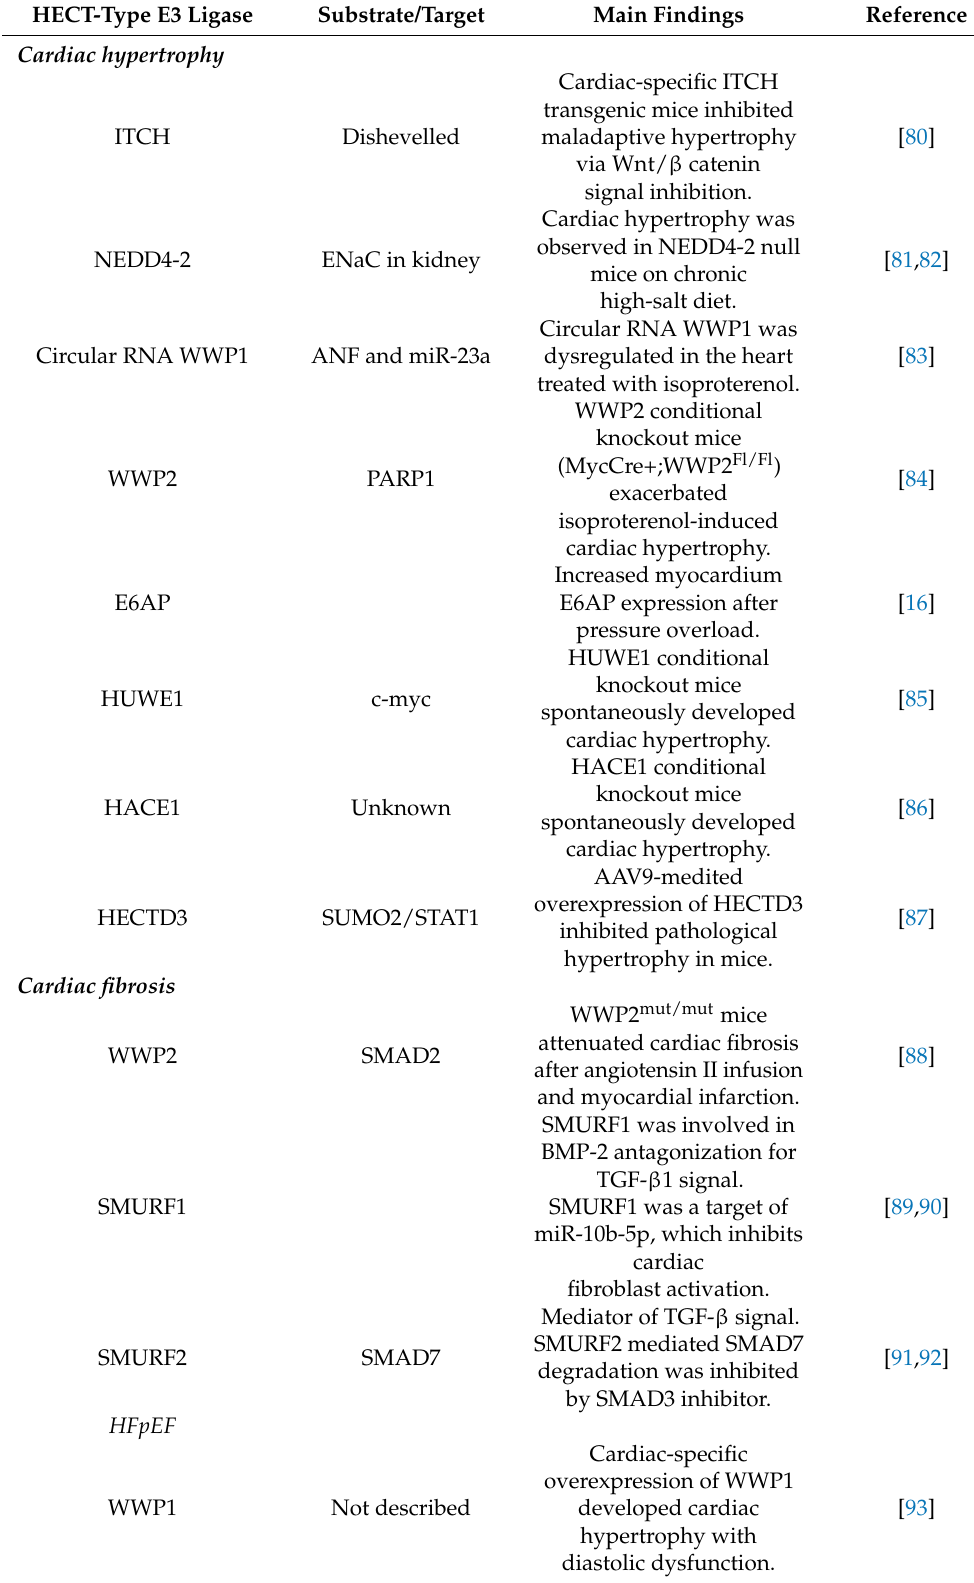
Table 1. HECT-type E3 ligase and cardiac